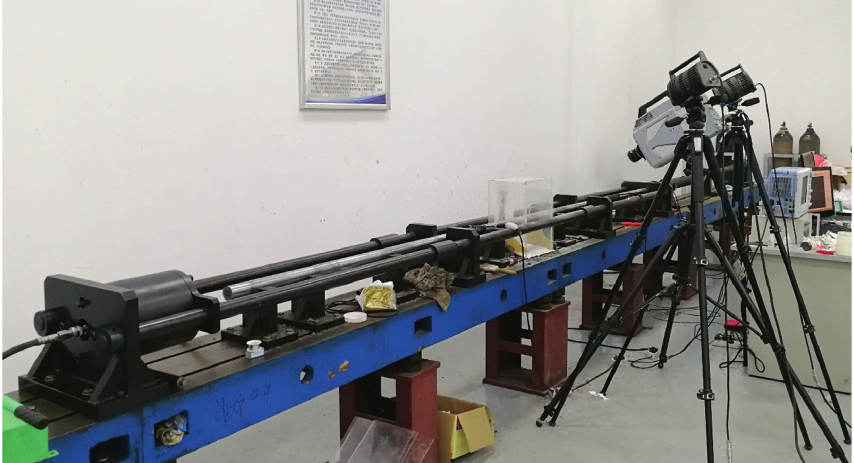
Figure 2: SHPB test